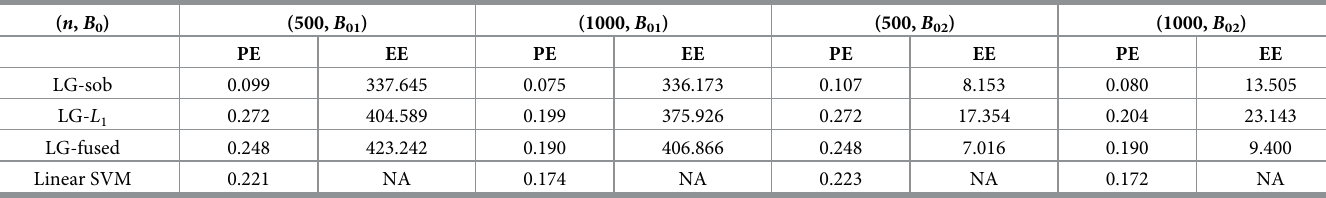
Table 1. Results of simulated example 1: Prediction error (PE) and estimation error (EE).